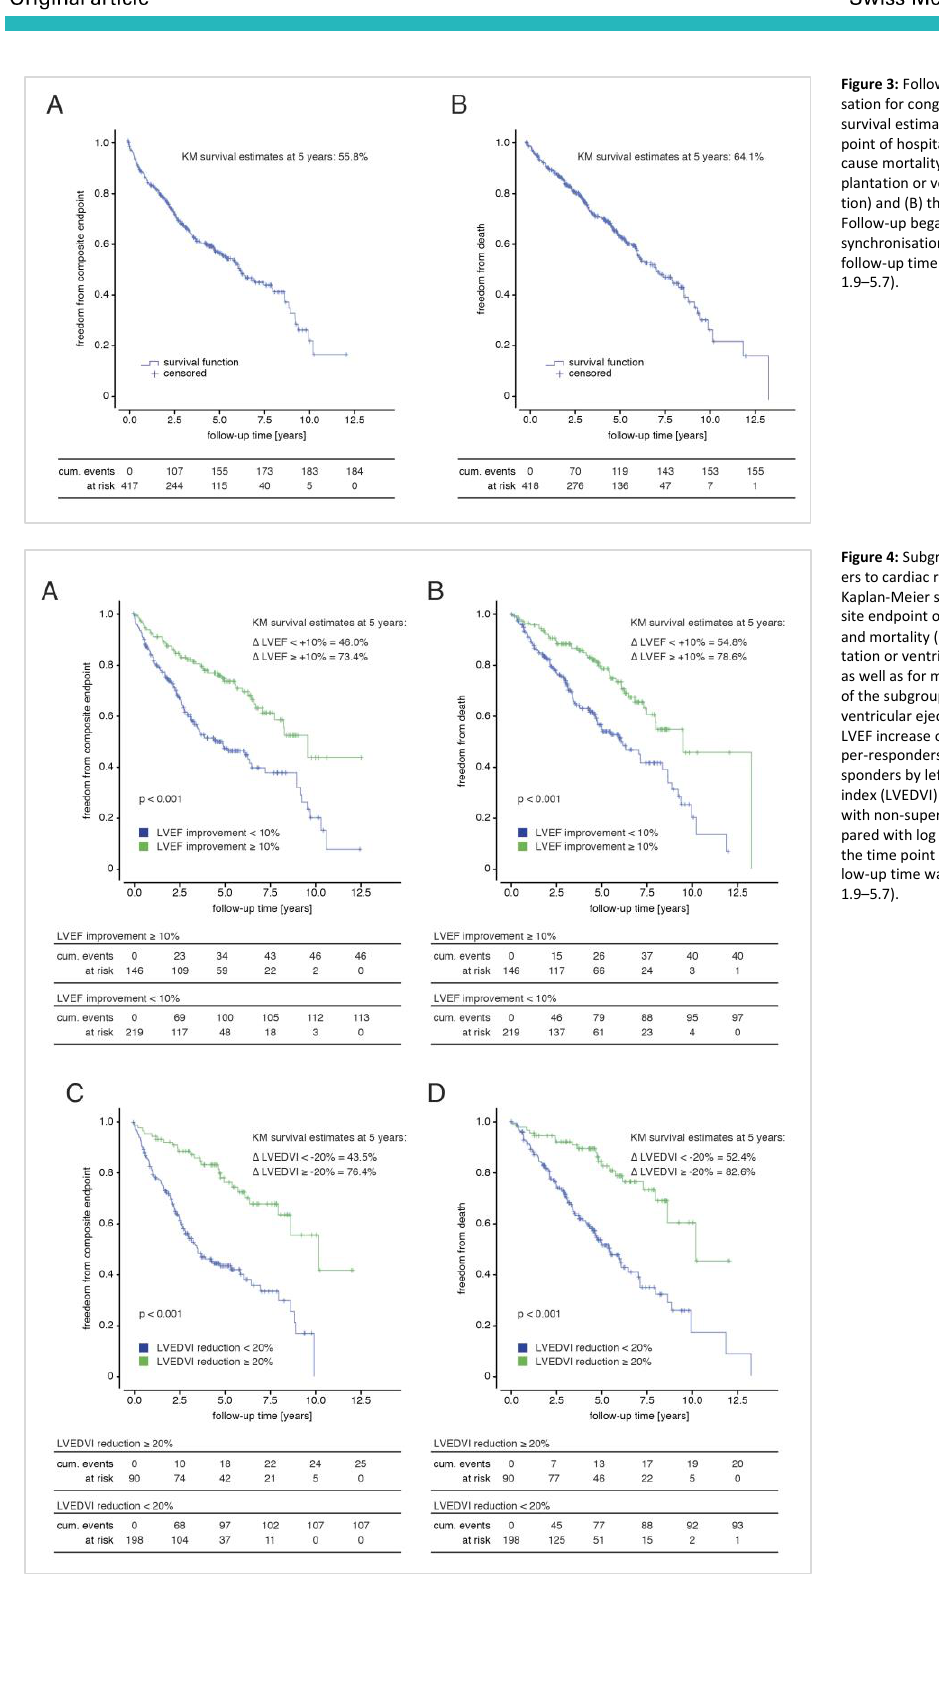
Figure 4: Subgroup analyses for super-respond- ers to cardiac resynchronisation therapy (CRT). Kaplan-Meier survival estimates for the compo- site endpoint of hospitalisation for heart failure and mortality (defined as death, heart transplan- tation or ventricular assist device implantation) as well as for mortality alone. (A, B) Comparison of the subgroups of super-responders by left ventricular ejection fraction (LVEF) (absolute LVEF increase of 10% or greater) with non-su- per-responders. (C, D) Comparison of super-re- sponders by left ventricular end-diastolic volume index (LVEDVI) (reduction of 20% or greater) with non-super-responders. Groups were com- pared with log rank tests. Follow-up began at the time point of CRT implantation. Median fol- low-up time was 3.6 years (interquartile range